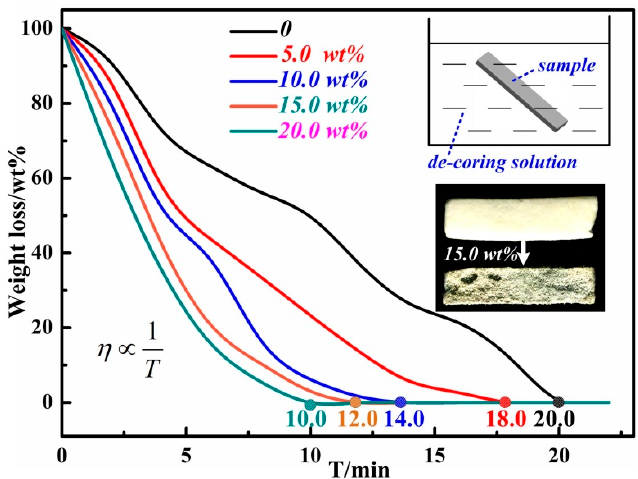
Figure 9. De-coring rate of SiO 2 ceramic molds with 0, 5, 10, 15, and 20 vol % Al additive.